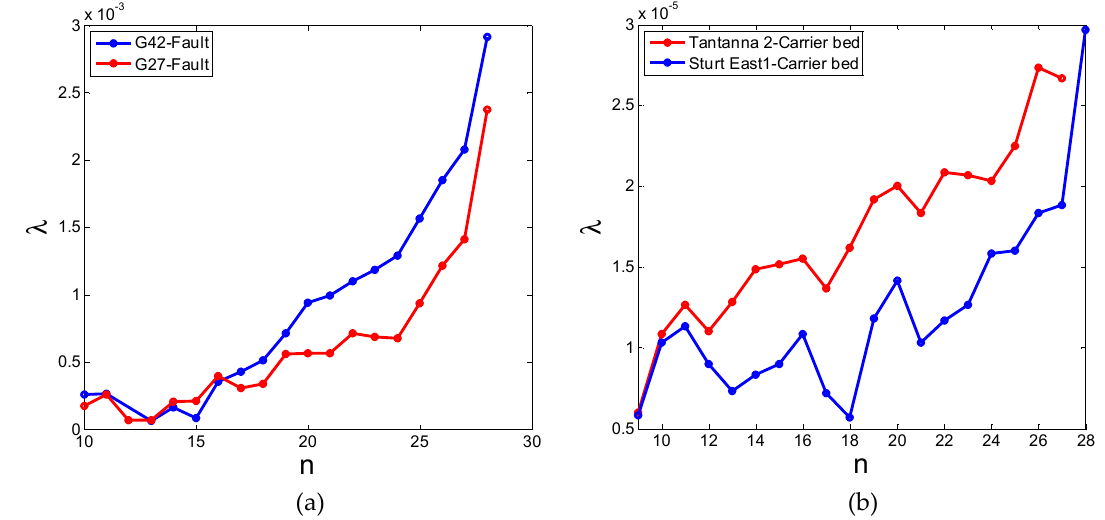
Figure 7. Filtration coefficients for hydrocarbons with difference carbon numbers for four different flow paths: ( a ) for wells G42 and G27, ( b ) for wells T2 and SE1.